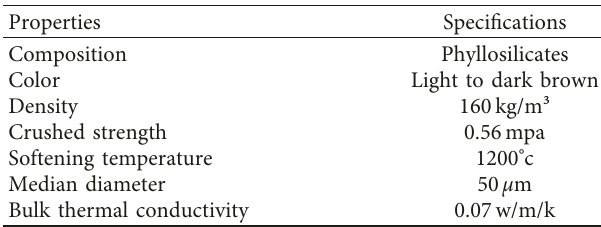
Figure 1: Images of lightweight aggregates. (a) Vermiculite. (b) Pumice. (c) Volcanic rock. (d) Coconut shell. Table 5: Specification of